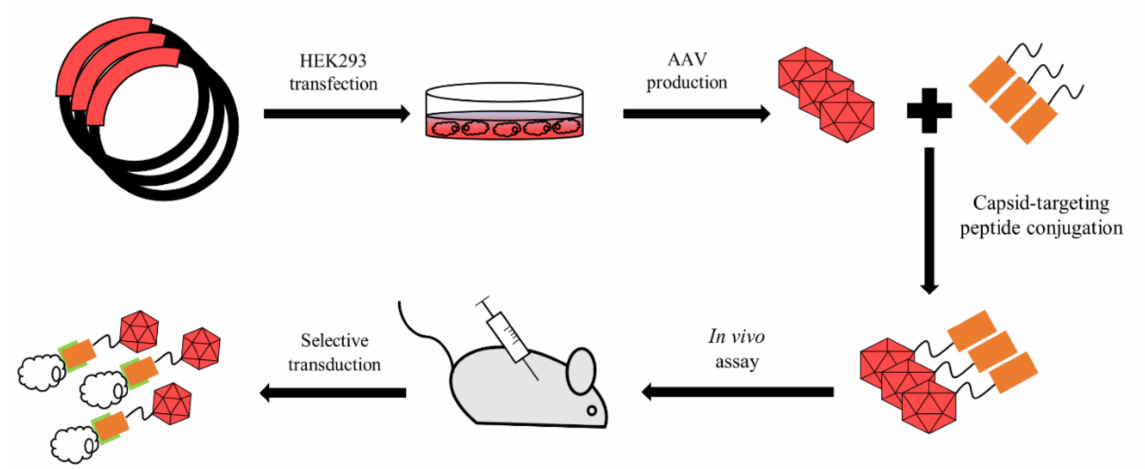
Figure 4. AAV bioconjugation. Producing cell line undergoes transfection with a plasmid encoding capsid of desired strains. Extracted virus is then conjugated with a targeting molecule via covalent bond. Conjugated capsid should be able to transduce target